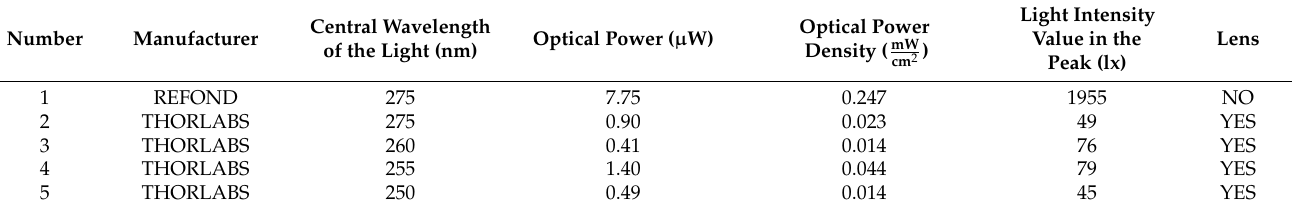
Table 1. The most important parameters of the